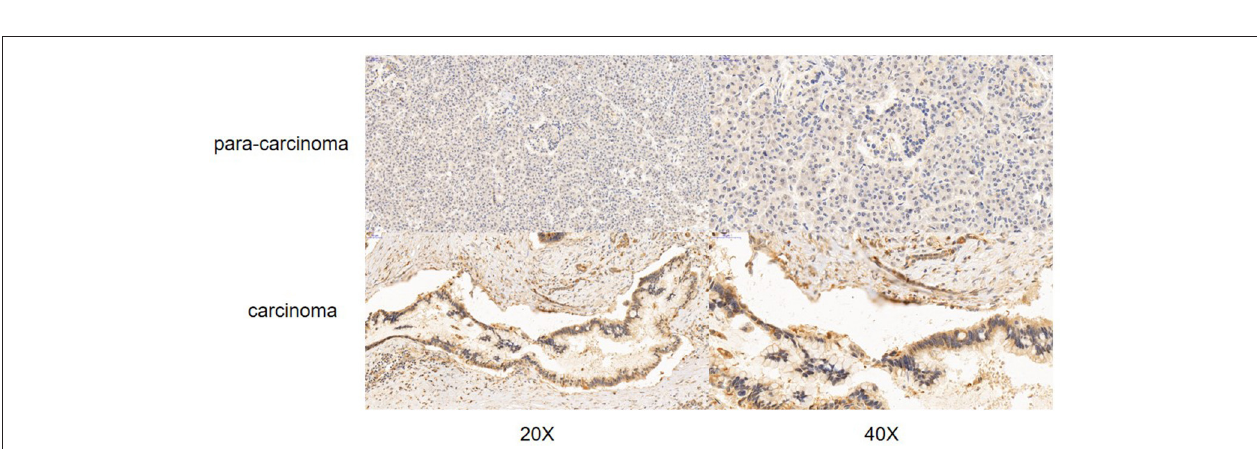
FIGURE 5 | Immunohistochemistry of S100A16 in PC tissues and adjacent tissues.